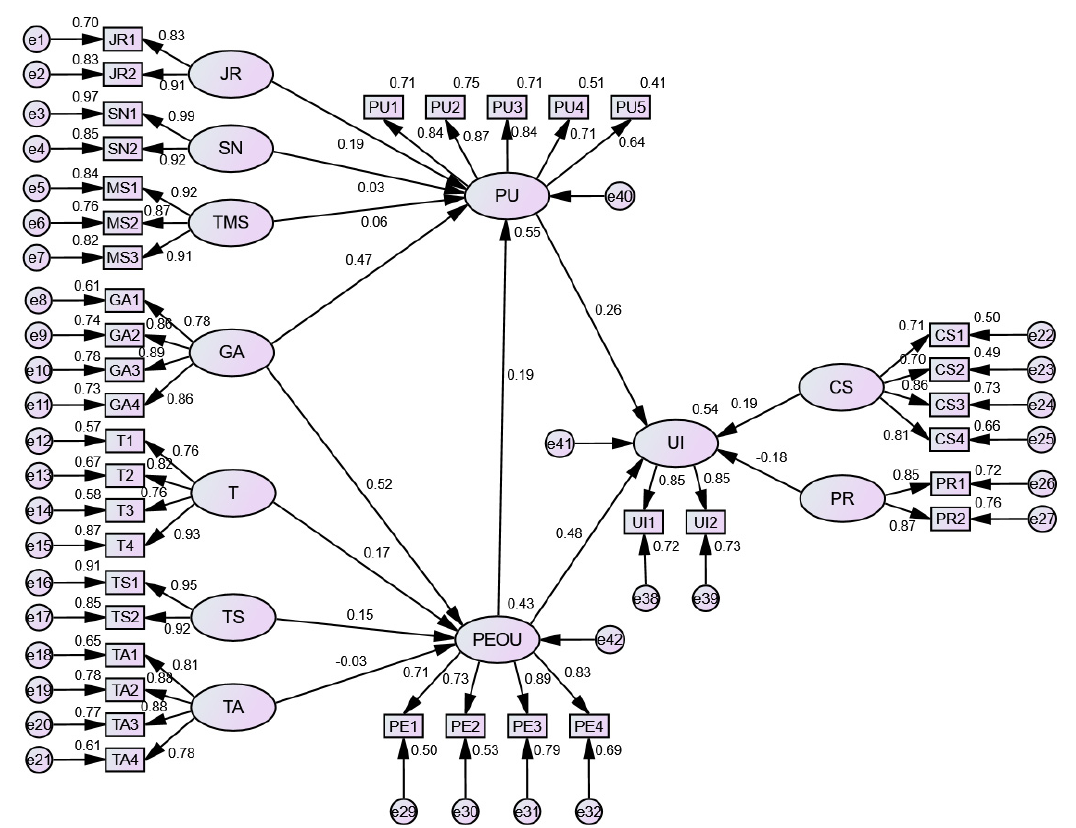
Figure 6. Standard path coefficients of ISSTAM. (Note: JR = job relevance; SN = subjective norm; TMS = top management support; T = training; TS = technical support; TA = technology anxiety; CS = cost savings; PR = privacy risk; GA = government action; PU = perceived usefulness; PEOU = perceived ease of use; UI = use intention.)